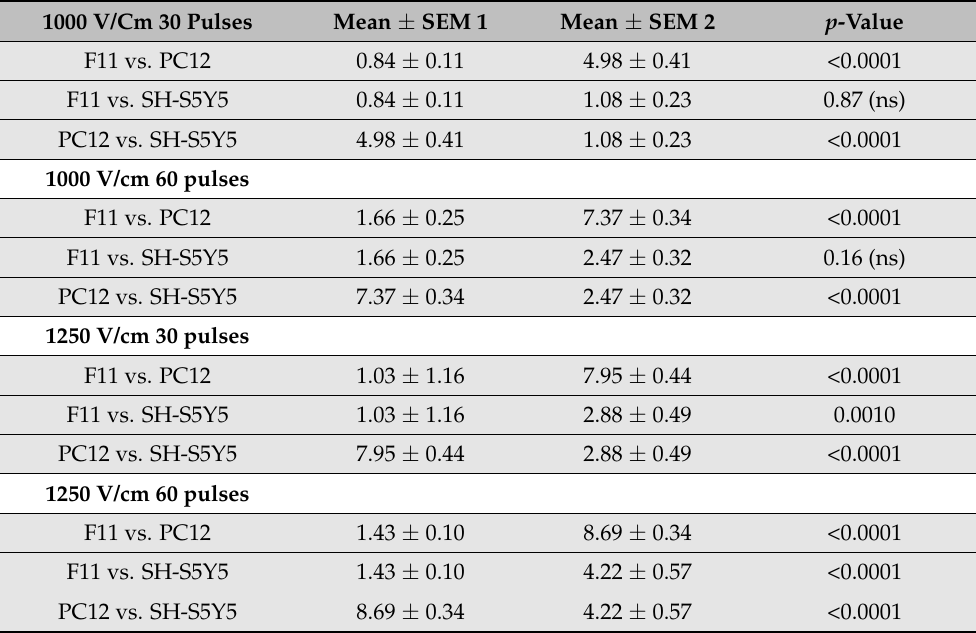
Table 1. Direct comparison of PI permeability among all neuronal lines at 0.5-h time point.